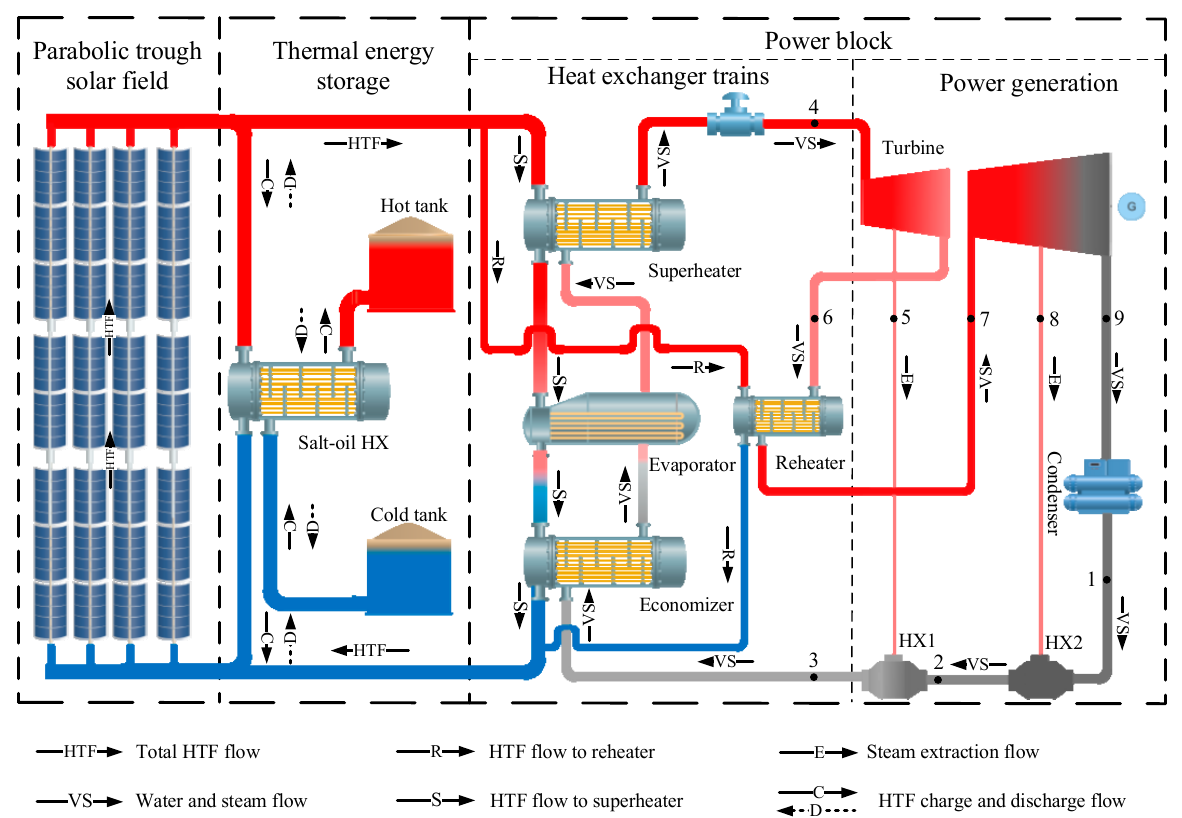
Figure 1. Schematic diagram and energy flows of a parabolic trough concentrating solar power (CSP) plant [22].